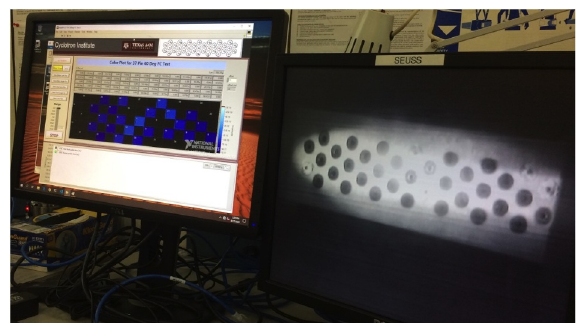
Figure 3. Photograph of Segmented Faraday Cup-Viewer (SFCV) being used to tune the alpha beam. The SFCV is 3D printed, with 37 screws which are wired to read the beam current at each disparate position across the target position. The surface has material adhered to it which phosphoresces in the presence of the beam. On the right is a video feed of the SFCV with alpha beam on the target position. On the left is the LabView program reading in the beam current o ff of each of the disparate screws.